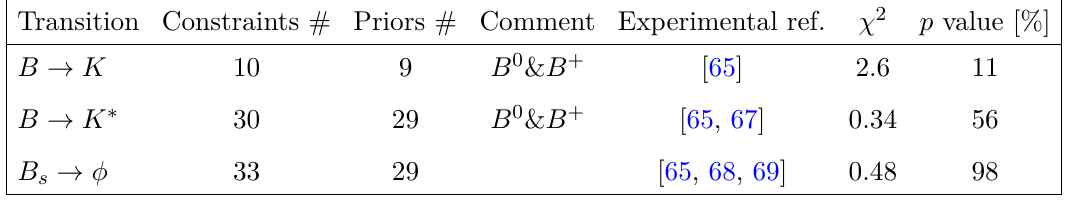
Table 3 . Summary of the goodness of fit for the posteriors of the non-local B → M FFs. The 17 unconstrained parameters discussed in the text do not enter the likelihood, which makes a goodness-of-fit discussion possible. We use the neutral and charged modes for the branching ratios of B → K ( ∗ ) J/ψ , as well as the two angular analyses of B decays, which differ in the s → φJ/ψ decay of the J/ψ to either muon or electron